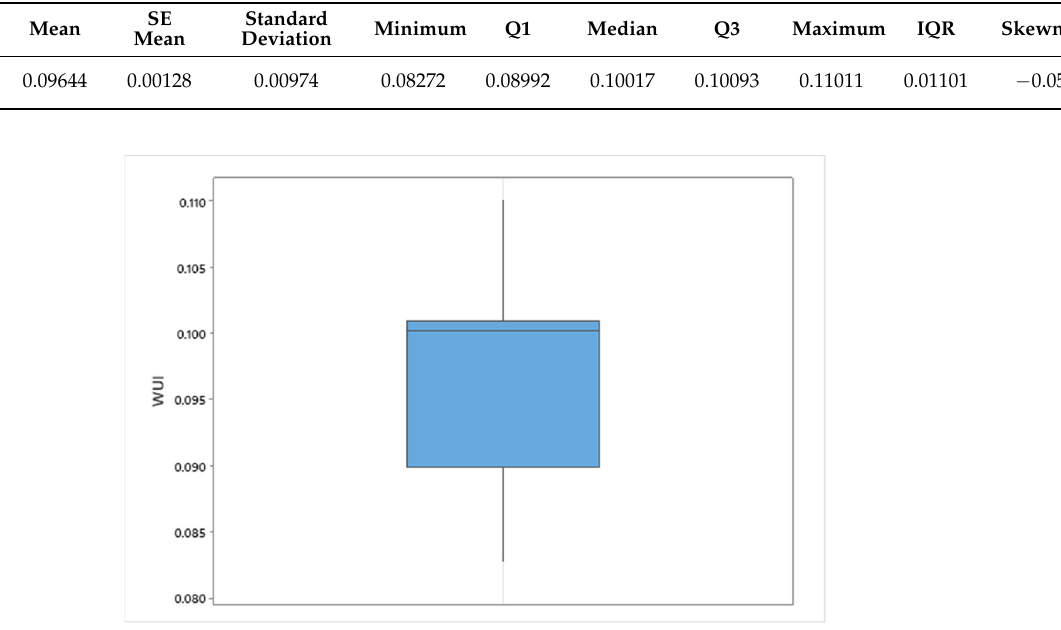
Table A4. Statistical summary of the calculated water values.